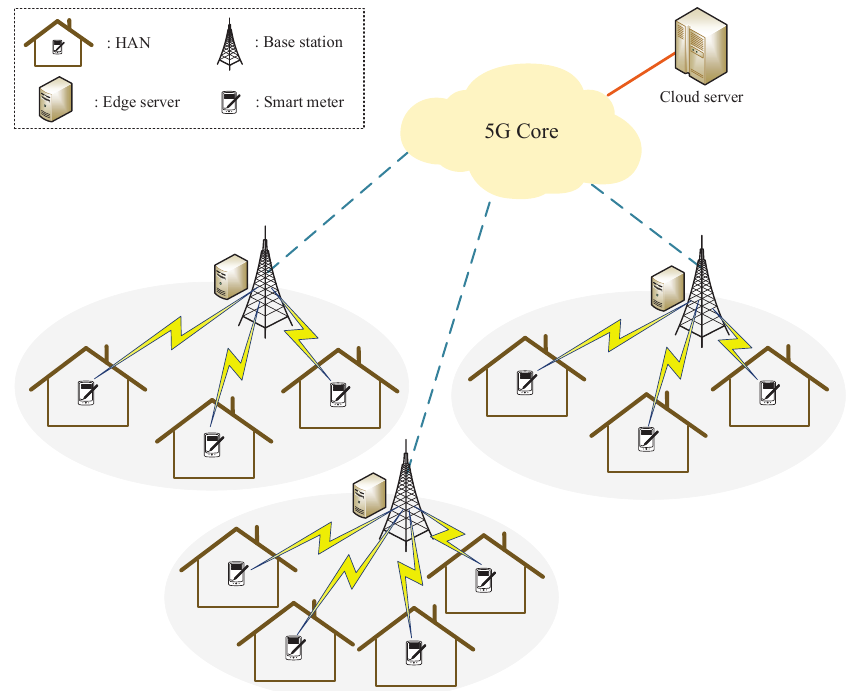
Figure 2. The 5G-based advanced metering infrastructure